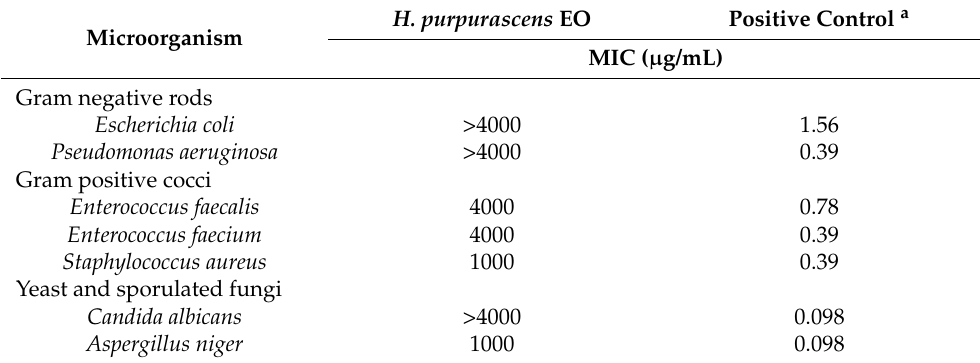
Table 3. Antimicrobial activities of Hedyosmun purpurascens essential oil.